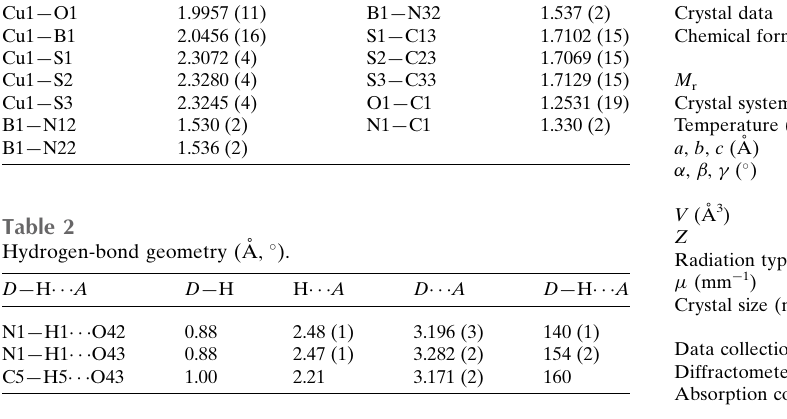
Table 3 Experimental details. Crystal data Chemical formula